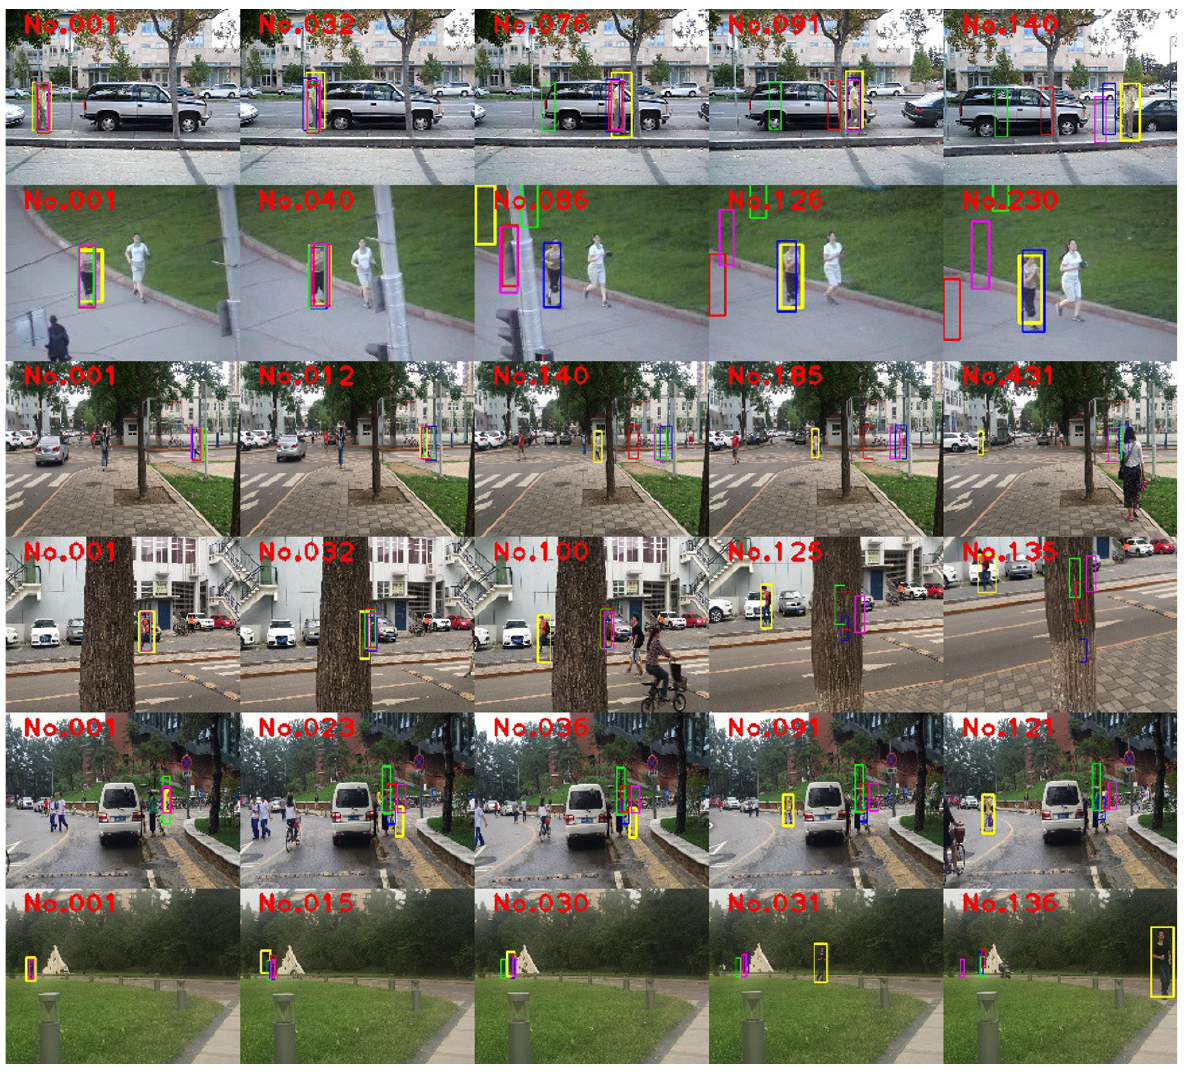
Fig. 3 Tracking results. Samples, top to bottom: David, Jogging, Occlusion 1 (multiple objects), Occlusion 2 (long-term occlusion and shaking), Occlusion 3 (long-term occlusion), and Frameskip. Yellow, blue, green, red, and purple rectangles represent tracking output of TDSC, KCF, CSK, CT, and IMT respectively.